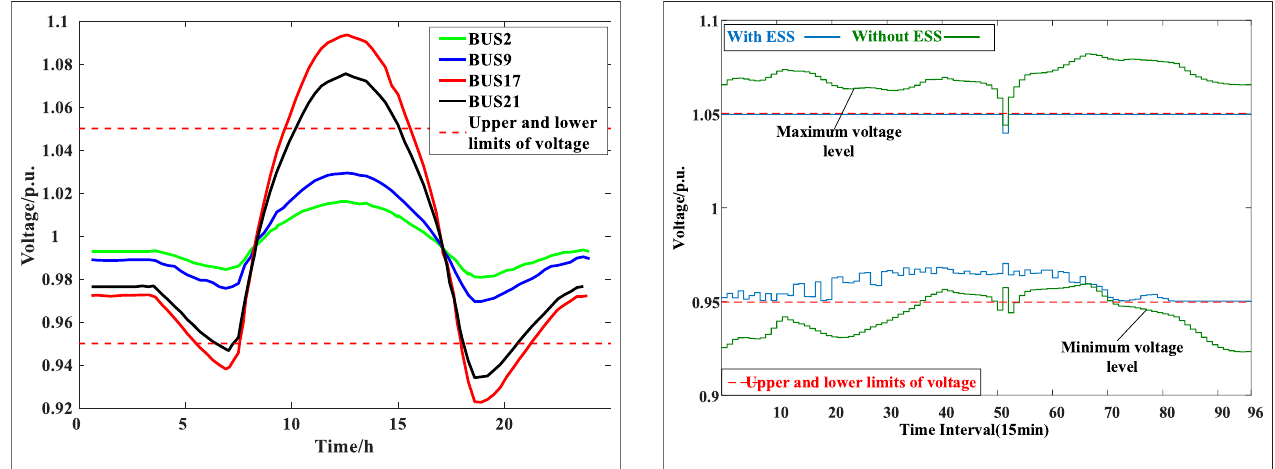
typical sunny day.